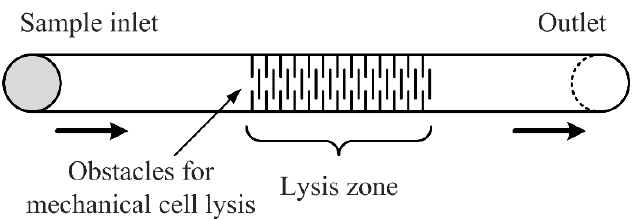
Figure 8. Schematic generalization of a microfluidic device for mechanical lysis.